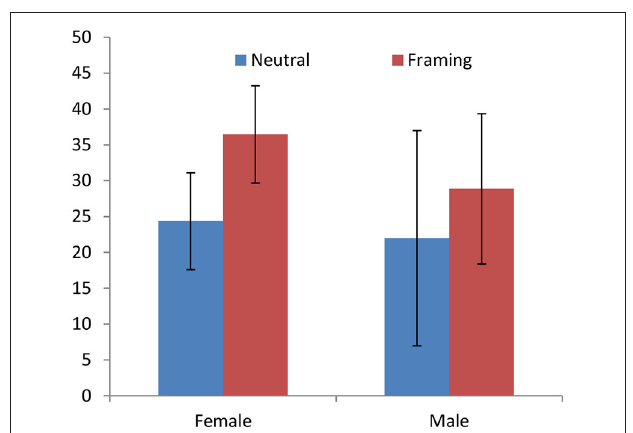
FIGURE 2 | Giving in the Dictator Game (data: Brañas-Garza et al., 2010) . Framing (“ relies on you ”) affects females but not males.